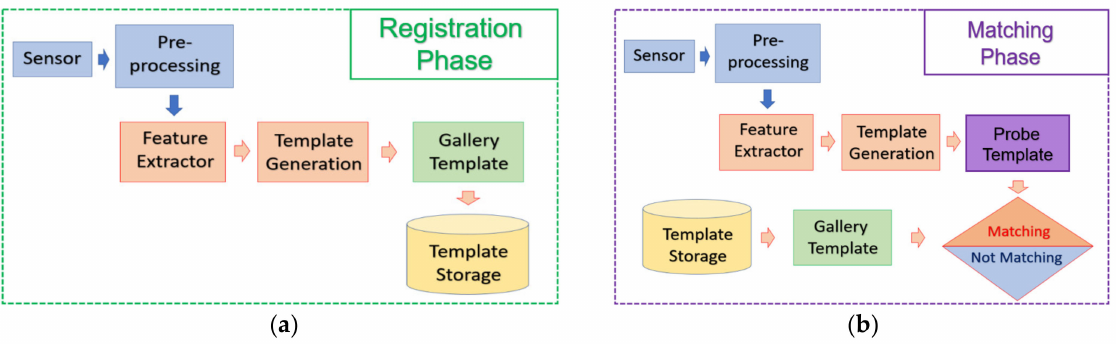
Figure 9. Common Phase in biometrics: ( a ) registration phase; and ( b ) matching